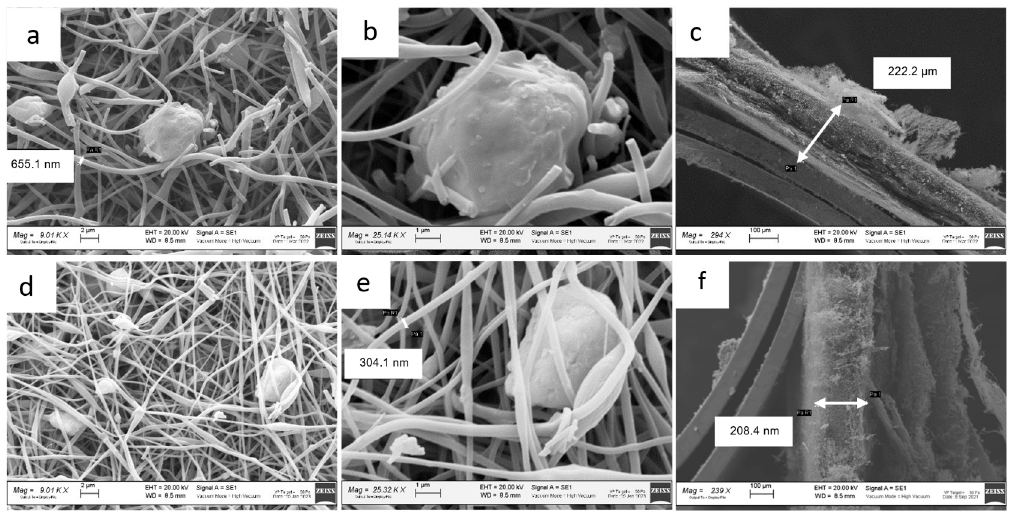
Figure 4. SEM images of 10%ZnS–GO/CNF sample: ( a ) and ( b ) at 9 and 25 kX, respectively, and ( c ) cross-section. SEM images of 30%ZnS–GO/CNF sample: ( d ) and ( e ) at 9 and 25 kX, respectively, and ( f ) cross-section.